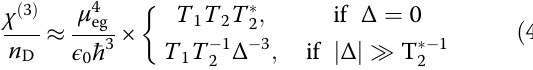
(cid:1) h ω is the photon energy, and labels R and T refer to resonant and transparent excitations. Values of μ eg are all taken from ref. 29 . All values for T 1,2 were found from photon echo and pump – probe performed under the DFWM conditions, except: a taken from ref. 21 . All values of the half-width, (cid:1) h = T (cid:2) 2 , were found from the small-signal absorption spectrum, except: b assumed equal to the 2p 0 half- width. x is the ratio of the intensities of the pump pulses from Fig. 2. L is the sample thickness and r 0 is the spot size. The dimensionless factor f , which is unity for zero loss and in fi nitely long pulses, appearing in Eq. (3) (and described in detail in the text), was found from integrating the propagation equations. The experimental values of E c were extracted from Fig. 2. Values of n D are given in units of 10 15 cm − 3 ; χ (3) L in units of 10 − 16 m 3 V − 2 ; χ (3) in units of 10 − 13 m 2 V − 2 ; and χ (3) /